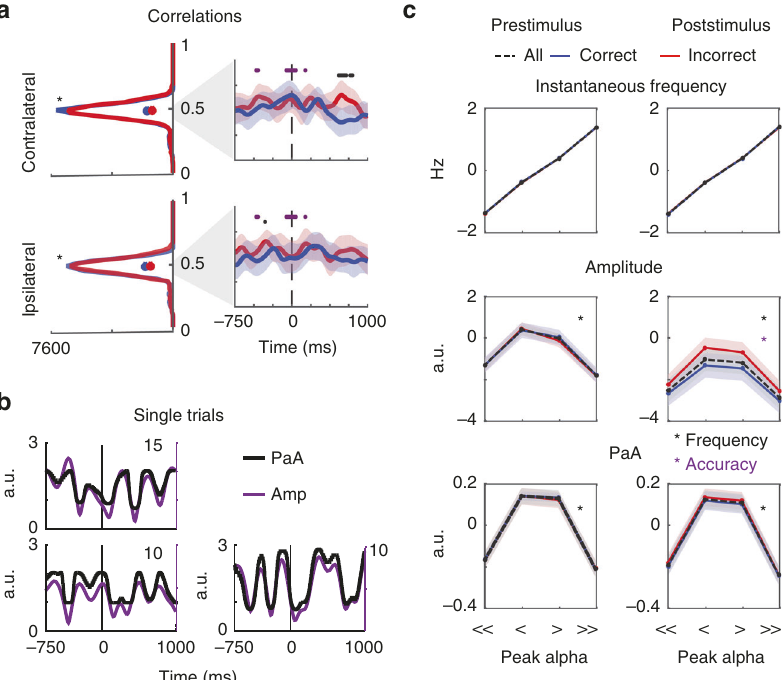
Fig. 6 Predicted alpha amplitude correlates with observed amplitude. a To assess how well PaA corresponds with alpha amplitude, we computed correlation values for each subject and electrode for each timepoint over the entire – 750 to 1000 ms peri-stimulus interval. Histograms show correlation values concatenated over all subjects, timepoints and electrodes on correct (blue) and incorrect (red) trials in the contralateral and ipsilateral electrodes. Stars on each panel indicate that all correlation values shown in these histograms are signi fi cantly different from correlations obtained with shuf fl ed LUTs (see Methods, Supp Fig. 4). Dots in histograms indicate the median correlations for that condition. Timecourses panels on the right show these correlations are relatively stable over time, where the y -axes of the plots run from 0.425 to 0.525, corresponding to the gray shaded area in the histogram. All dots indicate signi fi cant difference in the correlations between conditions, evaluated by comparing the obtained t- value with a null distribution of t- values computed by shuf fl ing the condition labels 10,000 times. This analysis was done on a timepoint-by-timepoint basis from − 500 to + 1000 ms, as indicated by the non-shaded areas. Main effects of are in black, whereas purple indicates an interaction. Gray dots indicate signi fi cance after FDR correction at 0.05. b Three example trials from three different subjects show that PaA shifts on single trials mirror those in alpha amplitude. The y -axis and traces for PaA are indicated in black, while those for amplitude are purple. Note that the y -axis range is different in each subplot to maximize visibility of amplitude and PaA (see Methods). c Trials were sorted according to mean pre ( − 350: − 50 ms) and post (350:650 ms) stimulus frequency. Average amplitude and PaA were then computed on these trials and timepoints. Trials were further split by accuracy, as indicated by blue and red lines. Signi fi cant differences were evaluated using a two-way repeated-measures ANOVA. Black stars indicate a signi fi cant effect of frequency, whereas a purple star indicates a signi fi cant effect of accuracy in the two-way